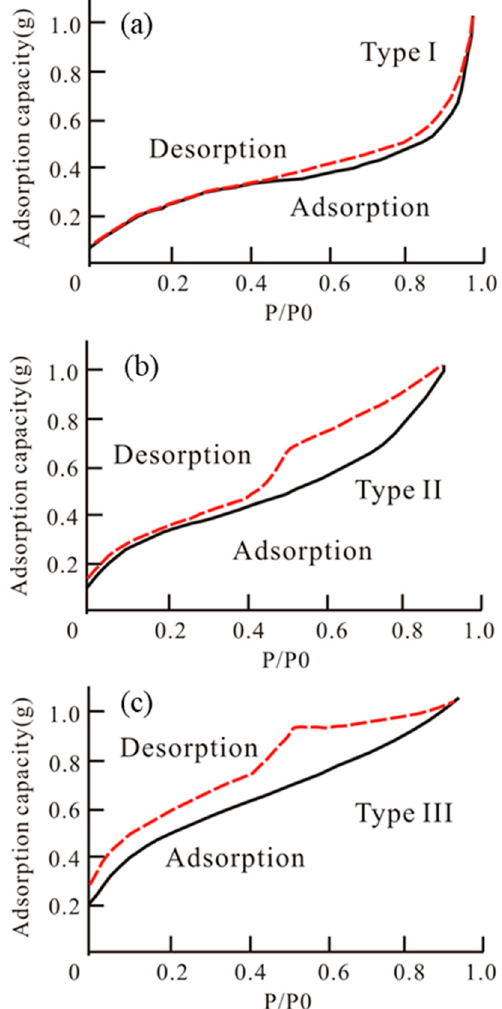
Figure 2. Typical low temperature N 2 adsorption loop type based on International Union of Applied Chemistry (IUPAC) classification (a: type I, b: type II, c: type III).